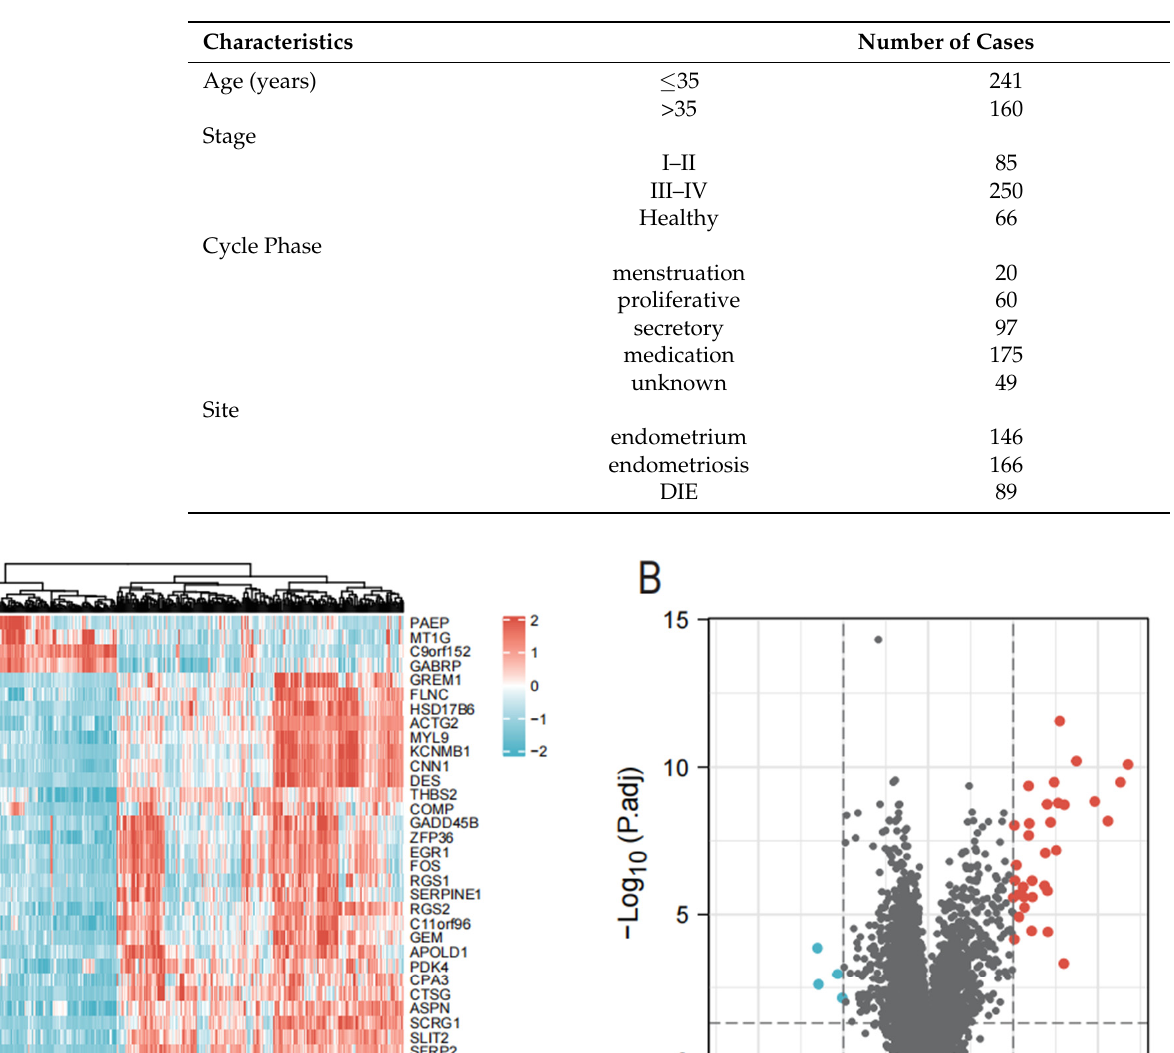
Table 1. Clinical characteristics of the GSE141549 dataset.